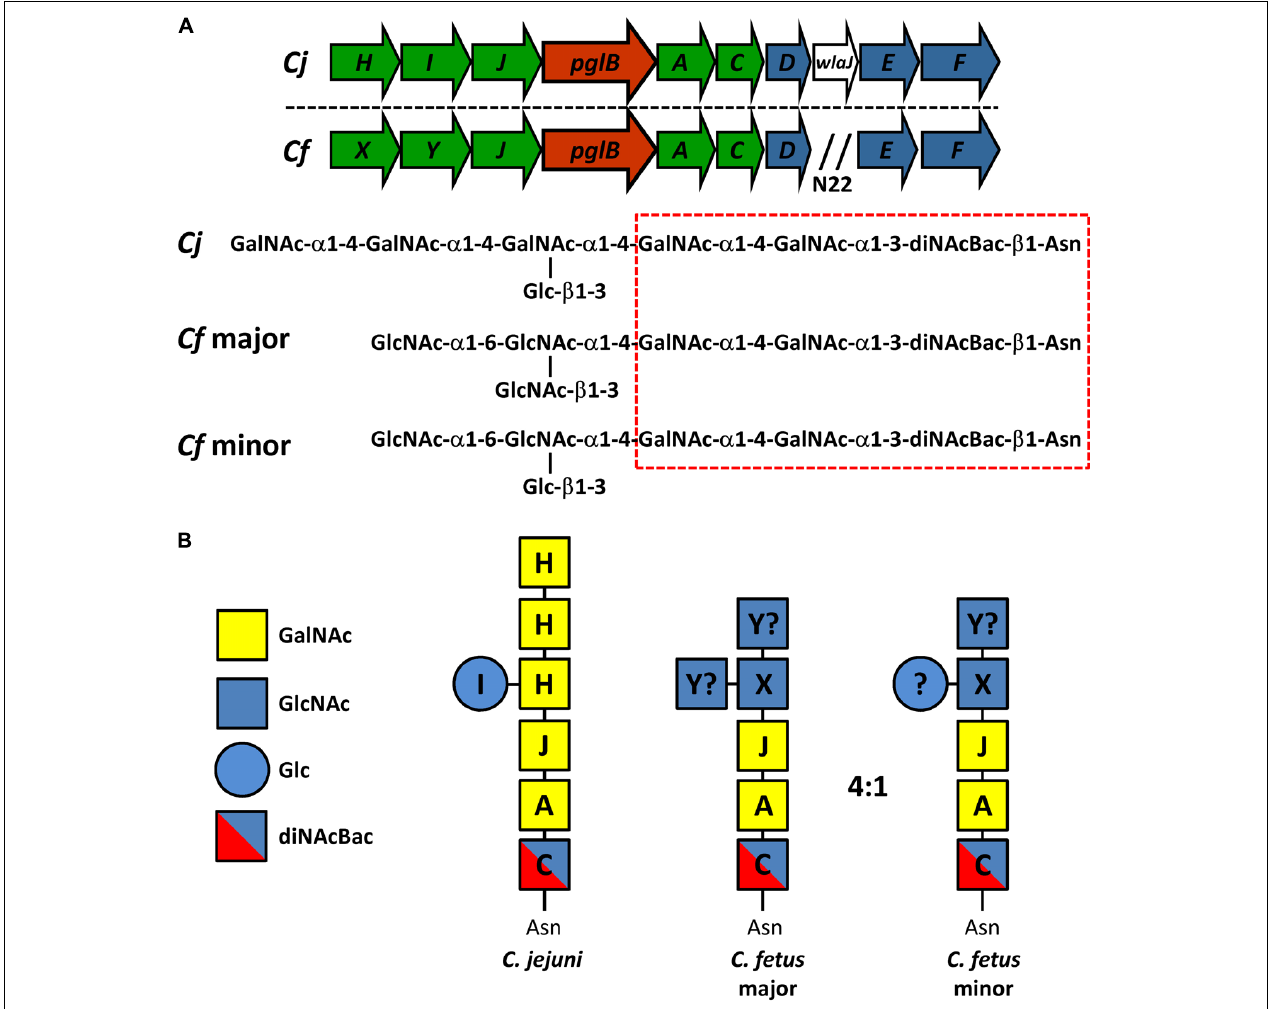
FIGURE 1 | Comparison of the N-linked protein glycosylation ( pgl ) pathway in C. jejuni and C. fetus . (A) The N-linked glycan structures and the genetic organization of the pgl locus for C. jejuni 11168 ( Cj ) and C. fetus fetus ATCC 27374 ( Cf ) (according to Nothaft et al., 2012) are shown. Genes encoding glycosyltransferases are in green, the oligosaccharyltransferase gene is in red, and genes for the biosynthesis of diNAcBac are in blue. N 22 indicates an insertion of 22 genes (between pglD and pglE ) in the Cff - pgl operon. The hatched red box indicates the conserved group of sugars at the reducing end. (B) Similar to Cj , we propose that Cf -PglC transfers diNAcBAc which is synthesized by Cj/Cf PglDEF (not shown) to undecaprenyl-phosphate (Nothaft and Szymanski, 2010). Subsequently, we show that Cf -PglA transfers the first α 1–3 linked GalNAc followed by the second α 1–4 linked GalNAc residue added by Cf -PglJ, comparable to the Cj homologs. To this trisaccharide, Cj -PglH transfers three α 1–4 linked GalNAc residues and Cj- PglI subsequently transfers the β 1–3 linked Glc branch (Kelly et al., 2006). For Cf , PglX most likely transfers the first HexNAc ( α 1–4 linked GlcNAc), but it remains to be determined if PglY can transfer the β 1–3 linked Glc or the remaining two GlcNAc residues in the major and the minor glycan forms. The question mark indicates that another enzyme outside the gene cluster could be responsible for the addition of those sugar